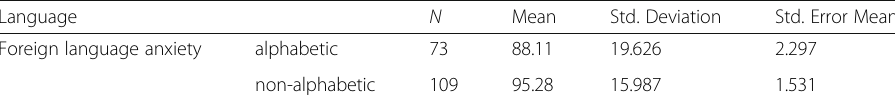
Table 4 Mean Differences between Alphabetic and Non-Alphabetic Language N Mean Std. Deviation